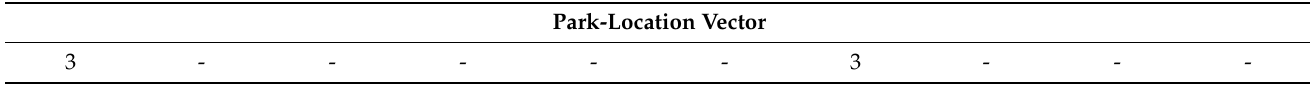
Table 5. Representation of a park-location